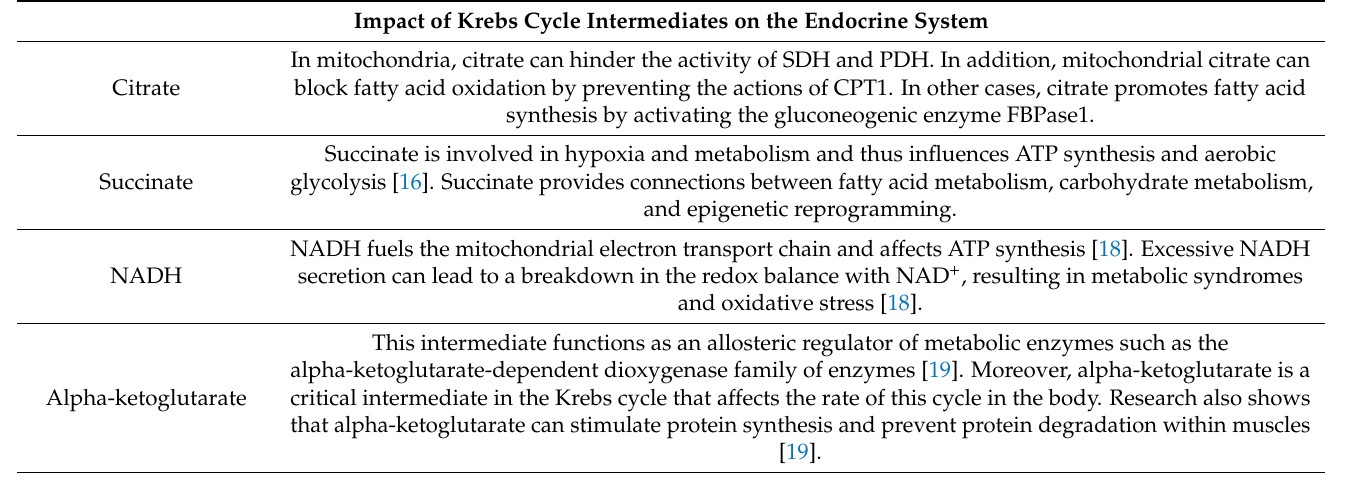
Table 2. Comparison of the impact of Krebs cycle intermediates on the endocrine system and the immune